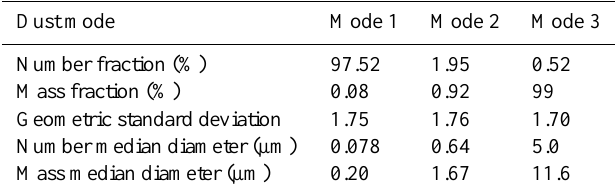
Table 3. Log-normal parameters of the AMMA size distribution used in DEAD coupled with SURFEX.